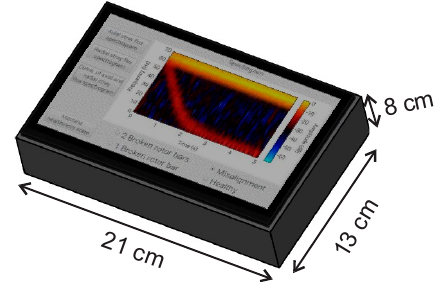
Figure 4. Block diagram of the proposed smart–sensor. BRB + MAL, broken rotor bar + misalignment; HLT, healthy motor; DAS, data acquisition system; A/D, analog/digital; STFT, short time Fourier transform; LDA, linear discriminant analysis; FFNN, feed–forward neural network.